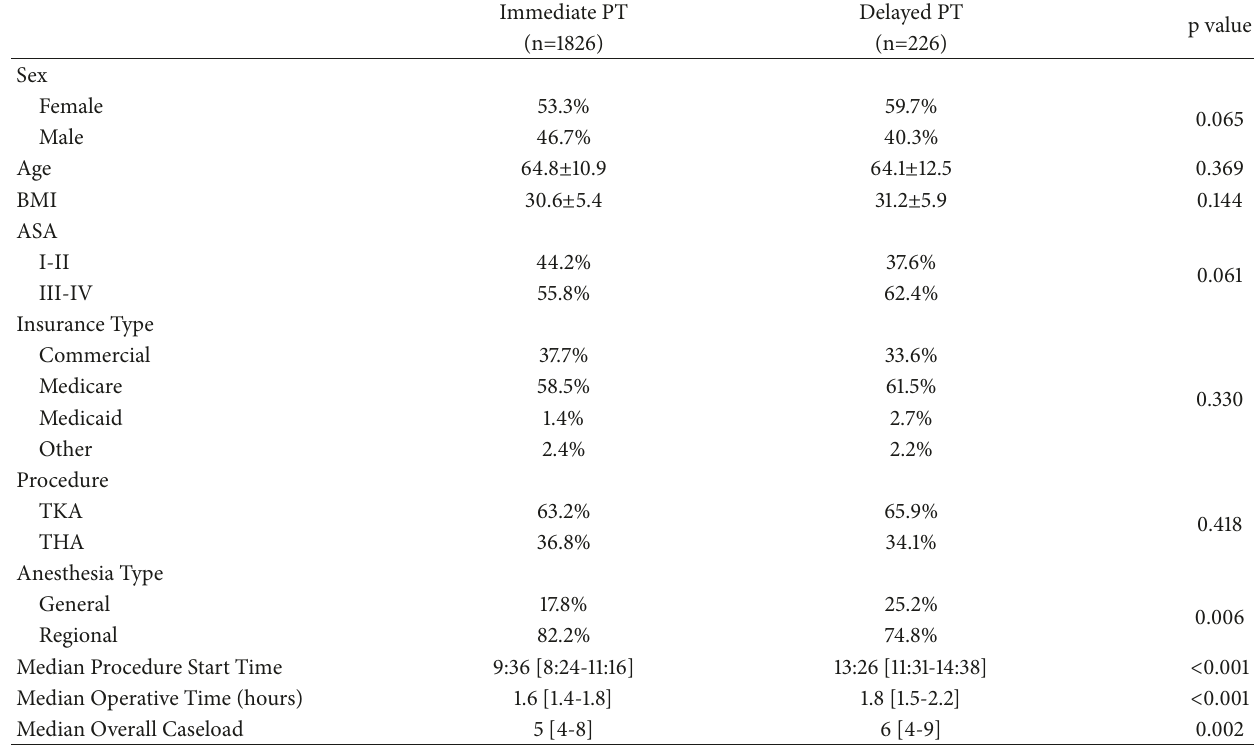
Table 1: Demographic and perioperative variables for immediate and delayed PT groups.